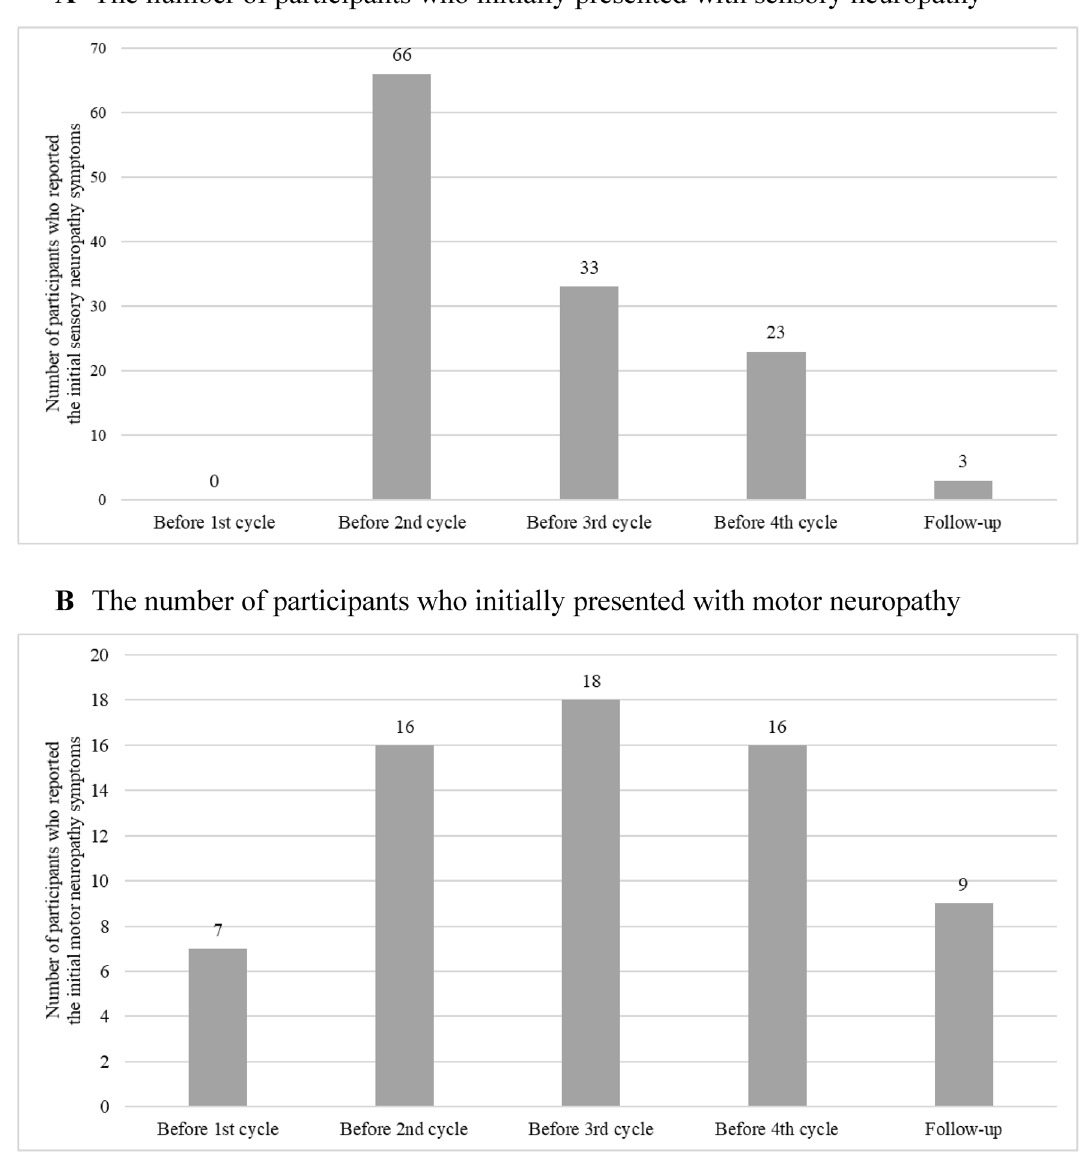
Figure 1. The number of participants who reported initial symptoms of ( A ) The sensory neuropathy symptoms, and ( B ) The motor neuropathy